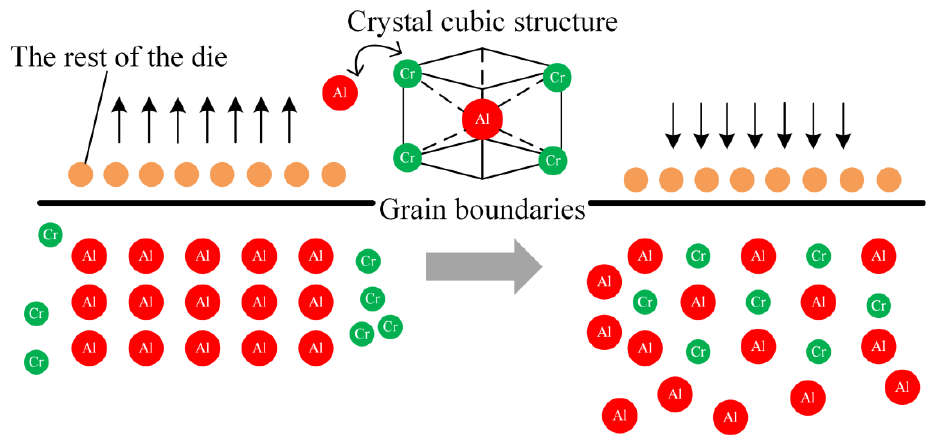
Figure 9. E ff ects of Cr and Al at grain